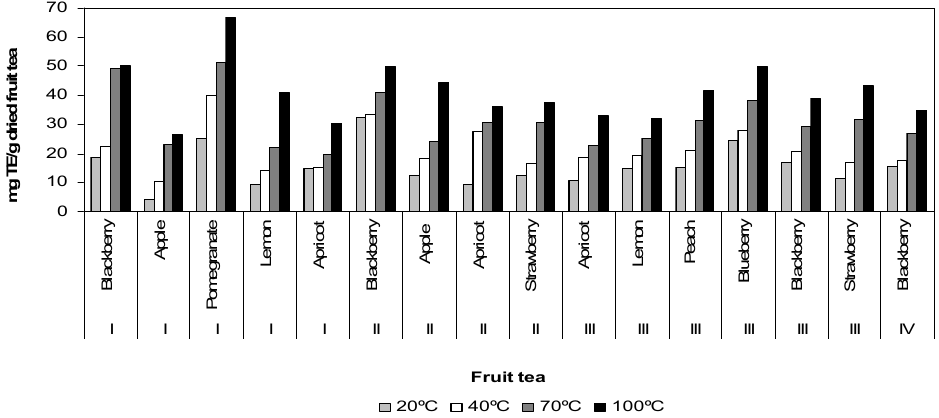
Figure 4. Antioxidant capacity of fruit tea samples affected by